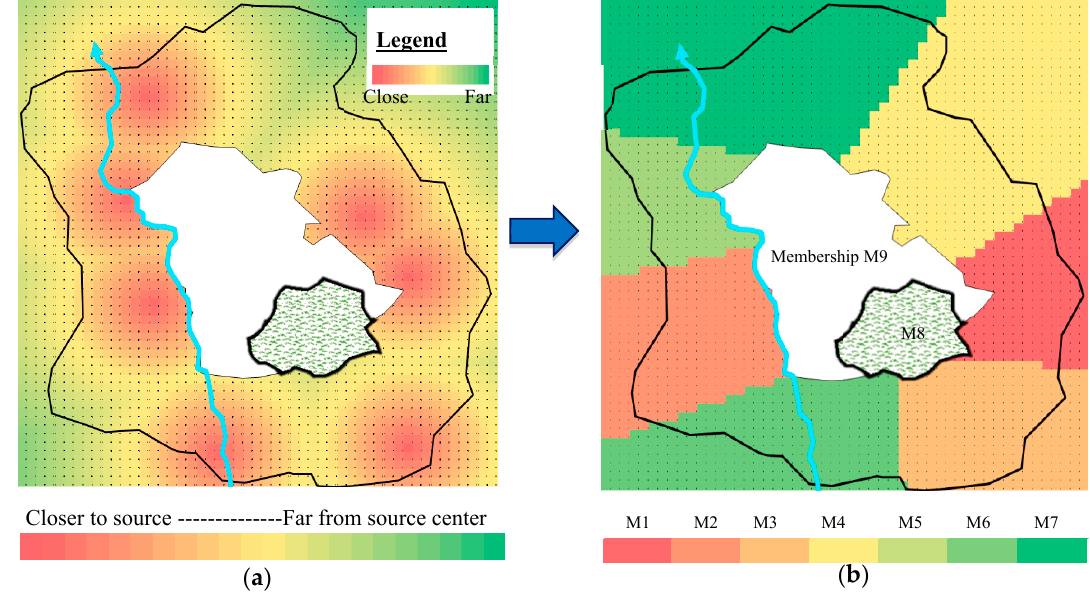
Figure 8. Maps showing parcel assignment (Minimized Euclidean norm) ( a ) and parcel membership-M based on source-demand distance ( b ).